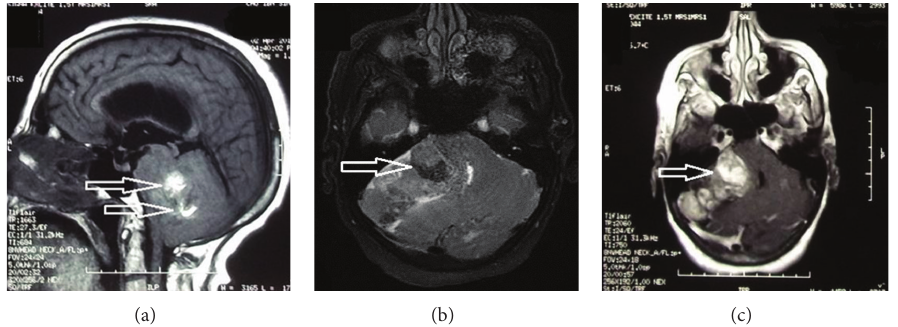
Figure 1: MRI of the brain in sagittal T1 (a), axial fat sat sequence (b), and axial T1 with gadolinium, respectively (c). Note the fat component (arrows in (a) and (c)) that turns hypointense after fat exclusion (arrow in (b)).